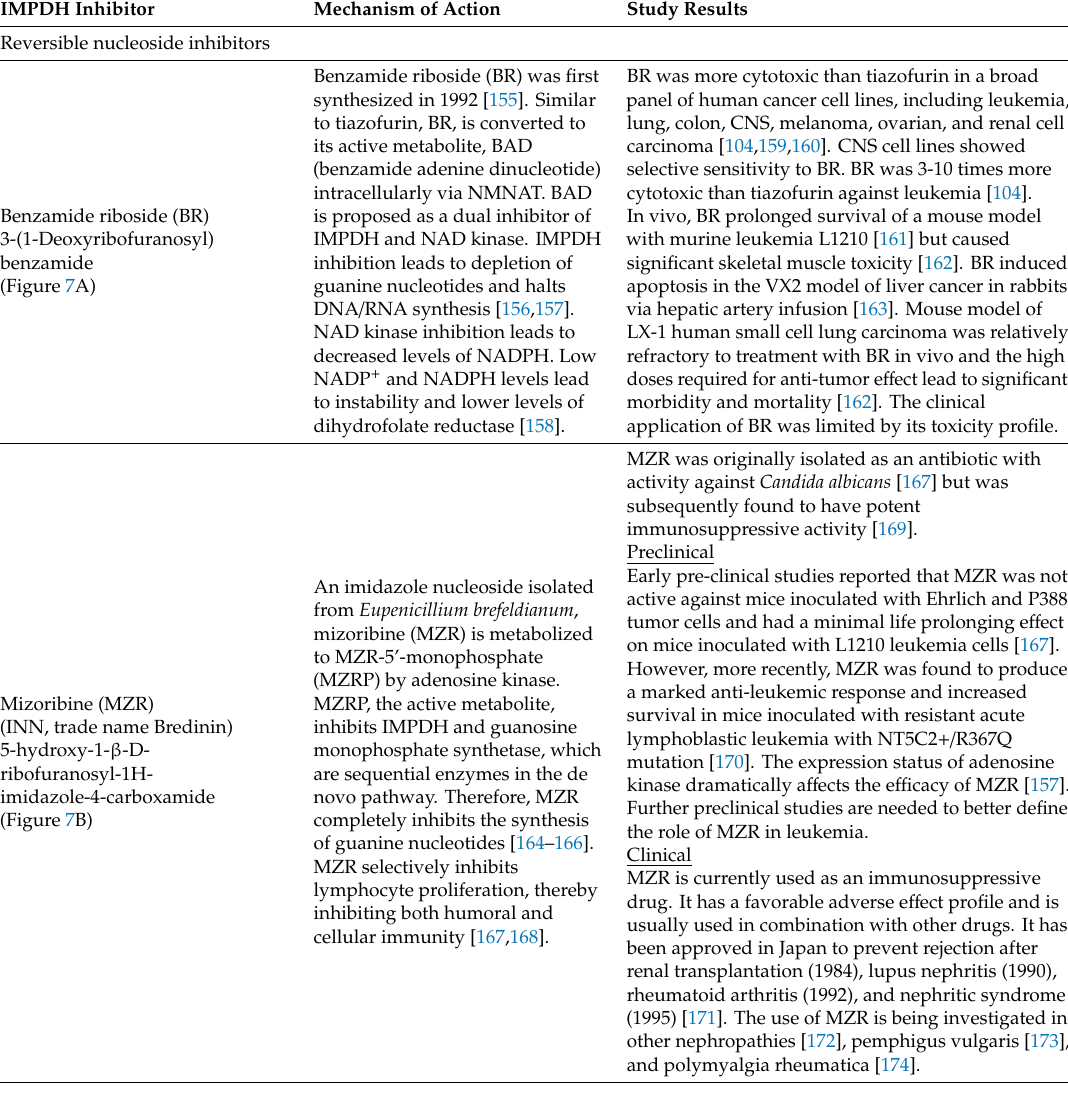
Table 6. Summary of preclinical studies of other IMPDH inhibitors as antitumor